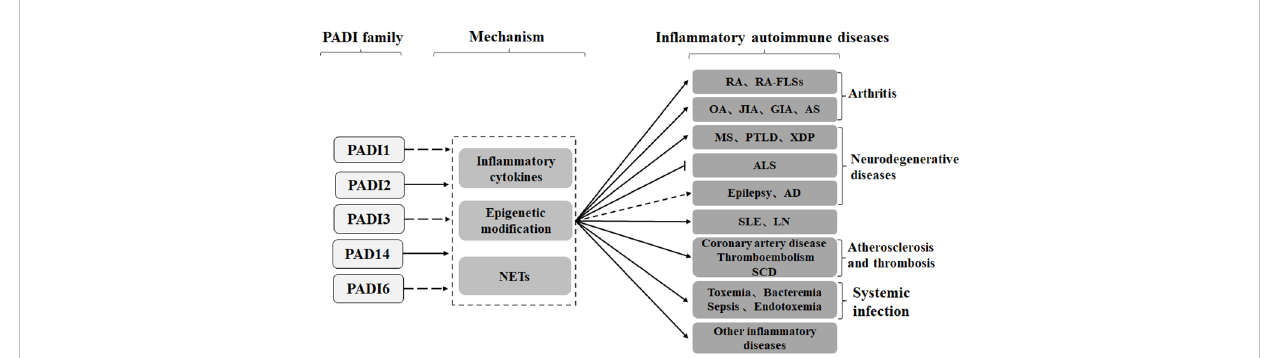
FIGURE 3 PADI2 and PADI4 in the PADI family can promote in fl ammatory autoimmune diseases, such as arthritis, neurodegeneration, arteriosclerosis and thrombosis, systemic lupus erythematosus and infection, through cytokines, epigenetics and NETs. No studies have shown that other members of the PADI family, other than PADI2 and PADI4, are involved in the development of in fl ammatory autoimmune diseases. Recent studies have shown that the PADI family can inhibit the development of ALS, but the role of the PADI family in epilepsy and AD is still